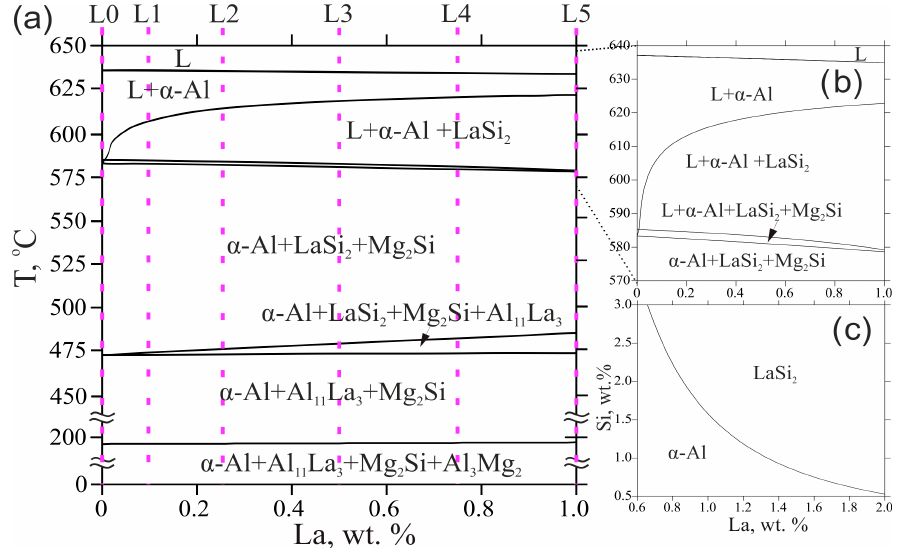
Figure 1. ( a ) Polythermal section of the Al-Mg-Si-La system at 4 wt.% Mg and 0.5 wt.% Si; ( b ) magnified polythermal section showing the change in liquidus and solidus temperatures; ( c ) liquidus projection of the Al-Mg-Si-La system at 4 wt.% Mg. The equilibrium phase mass fractions in the L1 (0.1 wt.% La) and L5 (1 wt.% La) alloys are